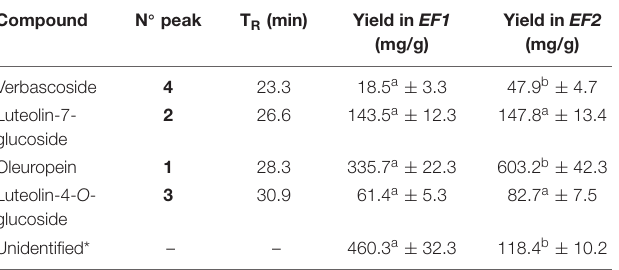
TABLE 2 | Quantitative and qualitative analysis of EF1 and EF2 phenolic compounds analyzed by HPLC. Compound N ◦ peak T R (min) Yield in EF1